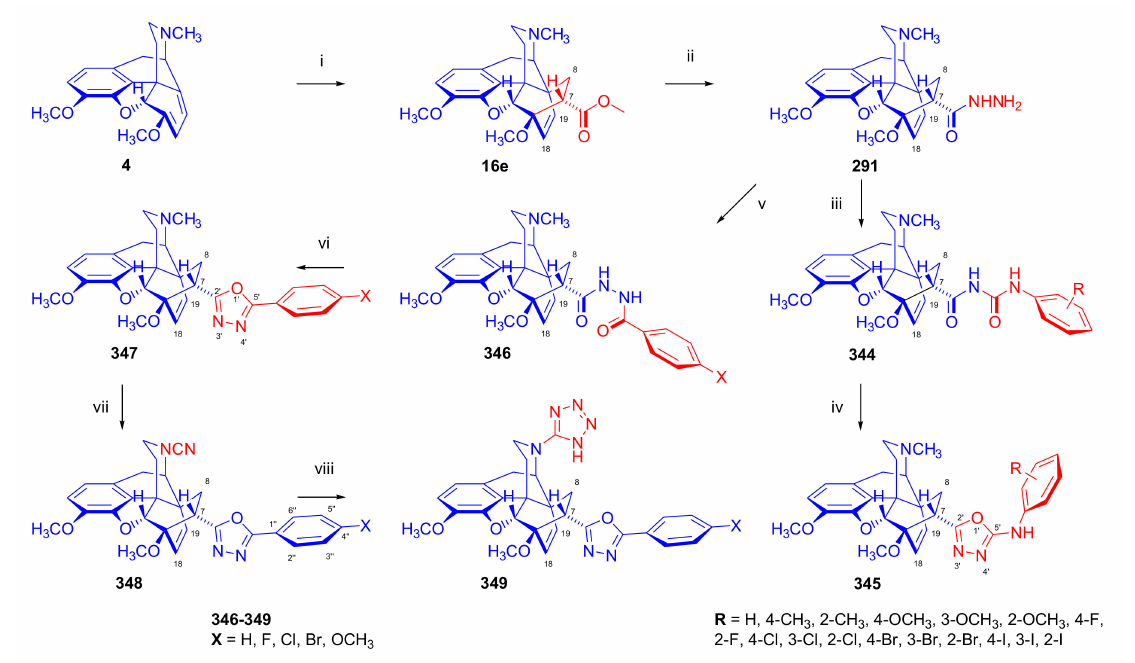
Figure 89. Synthesis of 7 α -(1,3,4-oxadiazol-2-yl)arenamine- and 7 α -(5-(halophenyl))-1,3,4-oxadiazole- substituted 6,14-ethenomorphinan derivatives. Reagents and conditions : (i): methyl acrylate,